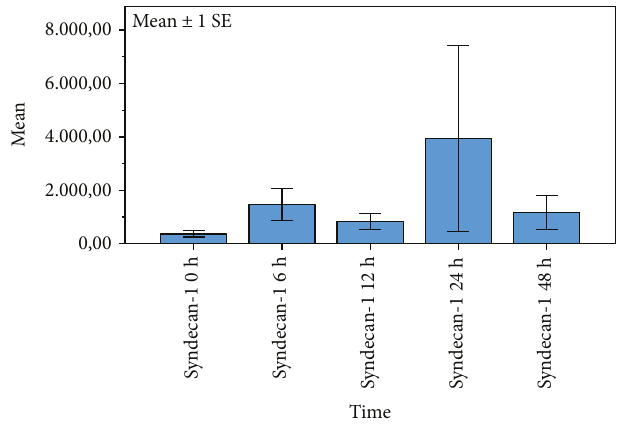
Figure 1: Serum levels of syndecan-1 within 48h after out-of-hospital cardiac arrest. Undulant serum levels of syndecan-1 without signi fi cant dynamics after resuscitation; bars represent mean values with error bars representing ± 1 SE. MANOVA analysis for repeated measurements; p = 0 907